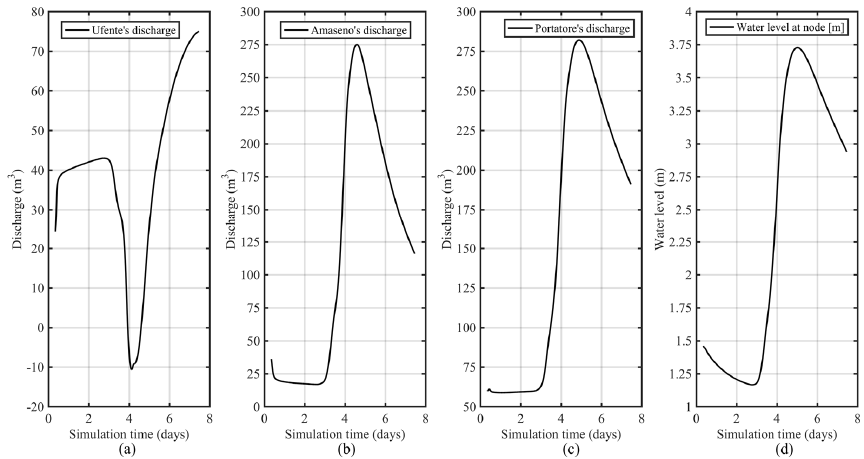
Figure 12. River discharges and free surface level trends at Ponte Maggiore’s junction: rivers ( a ) Ufente, ( b ) Amaseno, and ( c ) Portatore, and ( d ) water level at node.